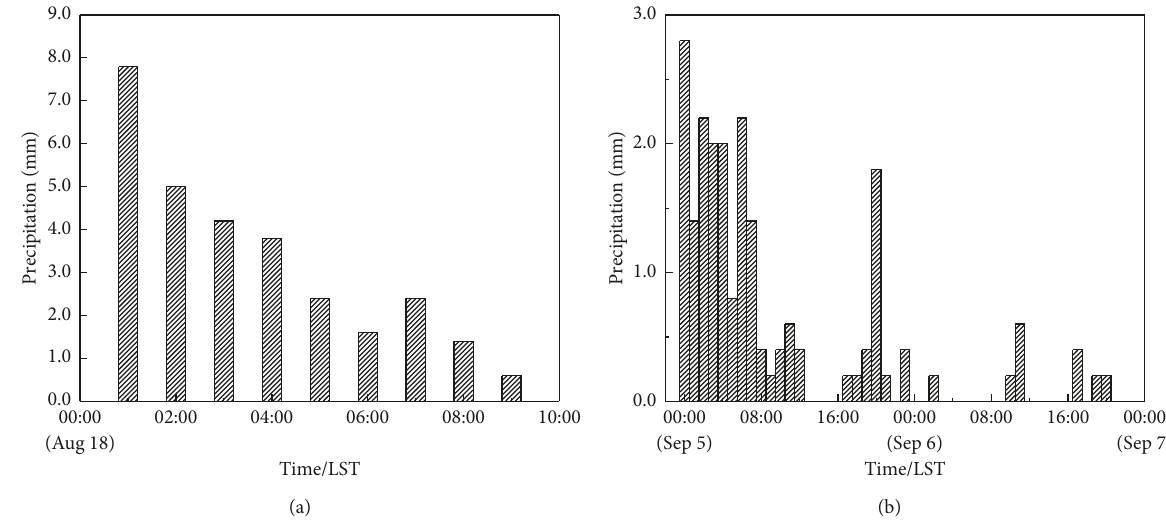
Figure 2: Hourly precipitation distributions of the two weather events: (a) August 18th; (b) September